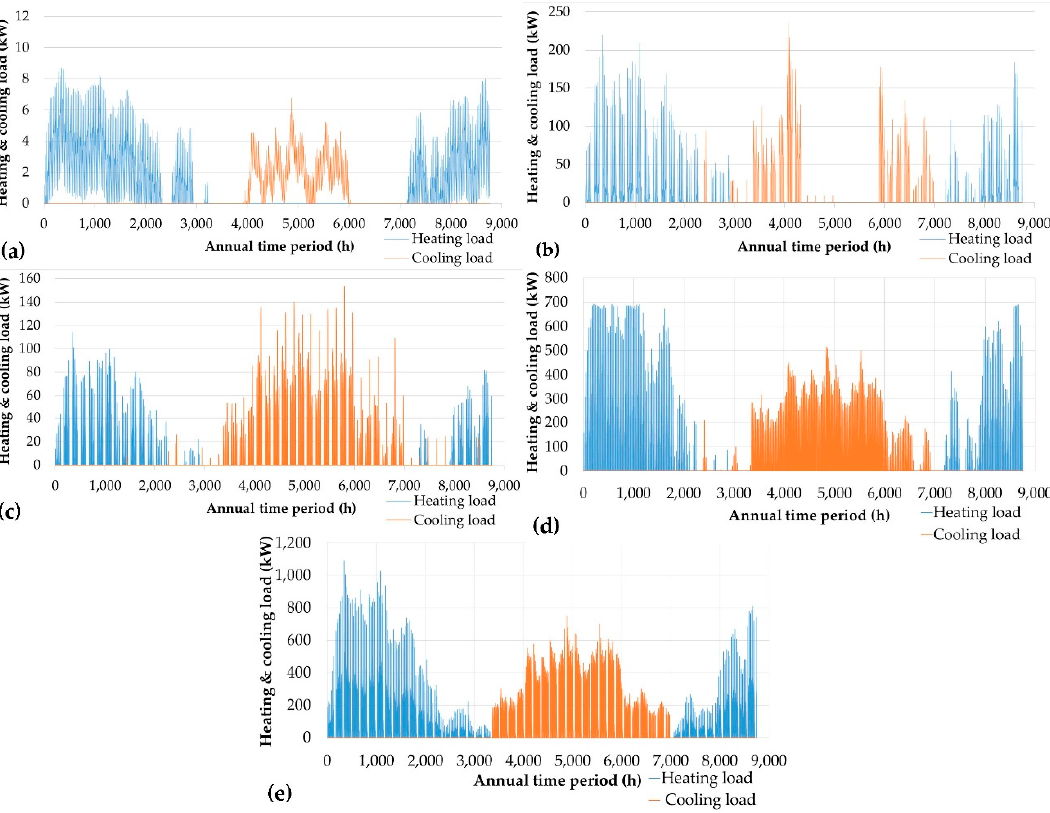
Figure 4. Annual fluctuation of the heating and cooling loads in the examined buildings and in the existing situation (( a ): residential building, ( b ): school building, ( c ): municipality hall, ( d ): NHMC, ( e ): Pancretan Stadium).